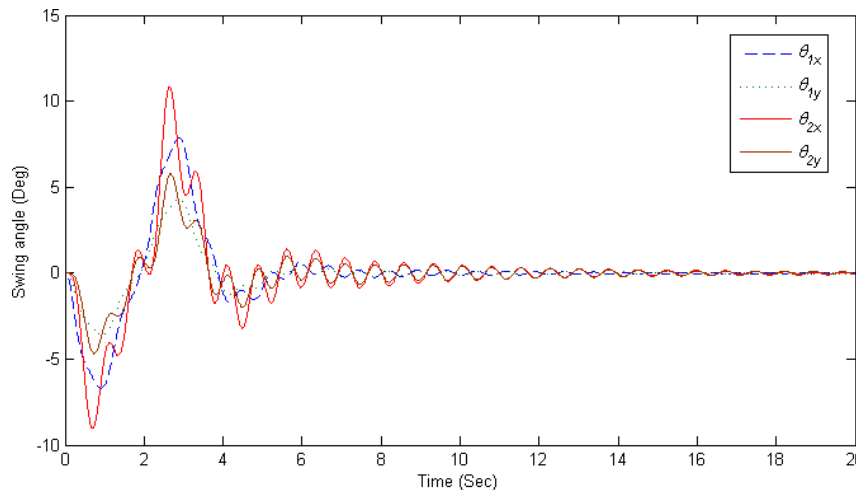
Figure 7. Swing angles for manoeuver of Fig. 6, showing active damping.